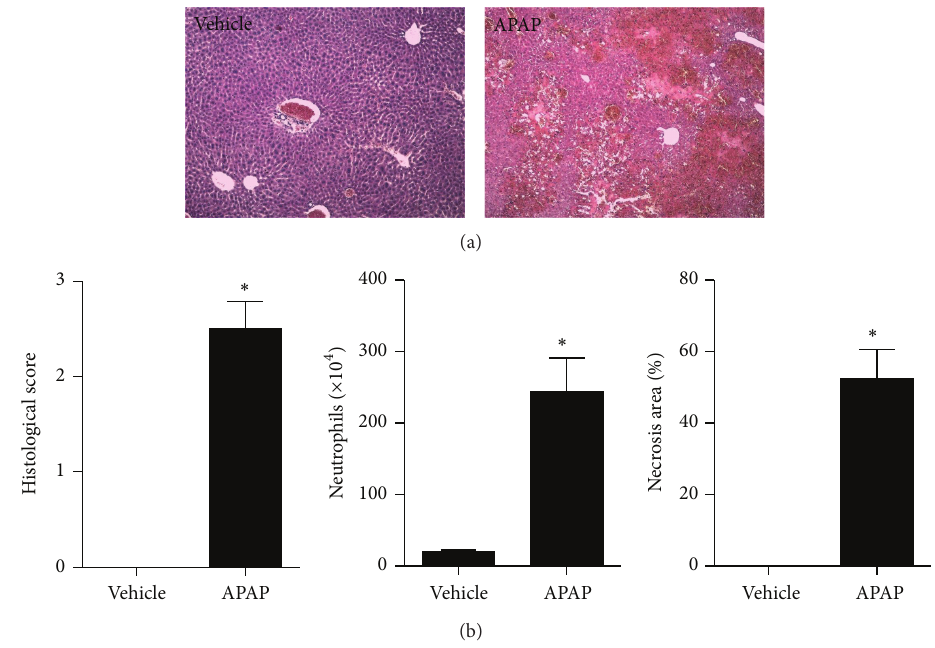
Figure 5: Histopathological assessment of acetaminophen-induced liver injury (APAP). (a) Liver histology (H&E) showing that while control mice have a healthy liver architecture and absence of necrosis, APAP-treated mice had several necrotic areas with leukocyte infiltration (green arrow). (b) Digital quantification of necrotic areas using ImageJ, histopathological score, and neutrophil infiltration (assessed by MPO levels) confirmed severe liver inflammation and necrosis induced by cocaine. ∗ Statistical significance in comparison to controls ( 𝑃 < 0.05 ). One-way ANOVA with Tukey’s post hoc test. Data are expressed as mean ± S . E . M ( 𝑛 = 6